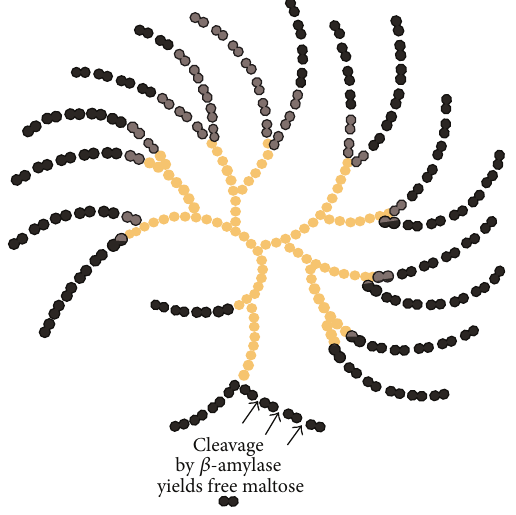
Figure 2: Structure of amylopectin showing a branched carbohy- drate polymer and the site of 𝛽 -amylase action yielding free maltose molecules (with